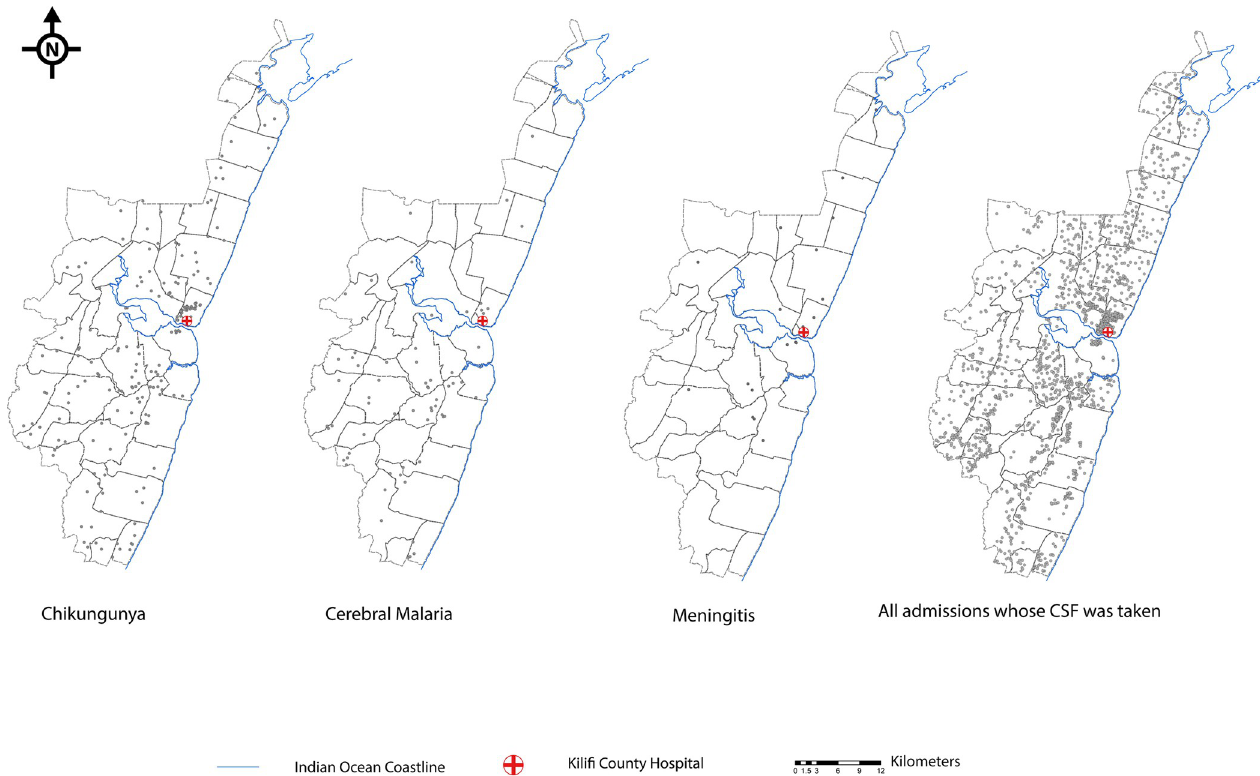
Fig 2. Distribution of children resident within the KHDSS that were admitted with neurological disease during the study period (2014–2018). Each point on the KHDSS map represents a child’s residential coordinates. The distribution of CHIKV-associated neurological cases is shown in comparison with that for children with cerebral malaria and meningitis or for all pediatric admissions that had CSF available for CHIKV RT-PCR screening. (Source: own elaboration using shapefiles and data from KEMRI-Wellcome Trust Research Programme). CHIKV, chikungunya virus; KHDSS, Kilifi Health and Demographic Surveillance System; CSF, cerebrospinal fluid; RT-PCR, reverse transcriptase polymerase chain reaction.